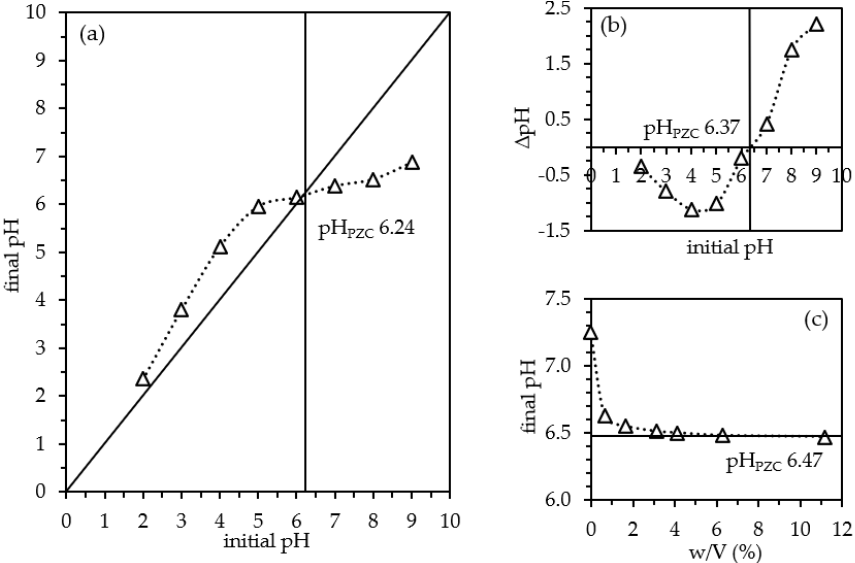
Figure 4. Point of zero charge determination: pH drift method ( a ) and ( b ) and mass titration method ( c ) (matrix: ultrapure water; t eq : 1 d; c(NaCl) = 0.03 M; pH 0 : 2–9; w / v : 0–11%; T = 22 °C; grain size: 8–16 mm).